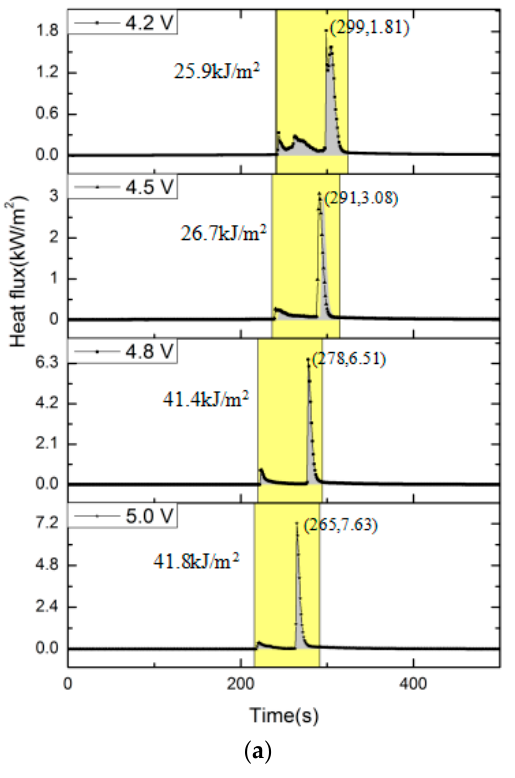
Figure 10. The typical curves of LIB flame temperature during tests: ( a ) NMC (4.2 V); ( b ) NMC (4.5 V); ( c ) NMC (4.8 V); ( d ) NMC (5.0 V); ( e ) LFP (4.2 V); ( f ) LFP (4.5 V); ( g ) LFP (4.8 V); ( h ) LFP (5.0